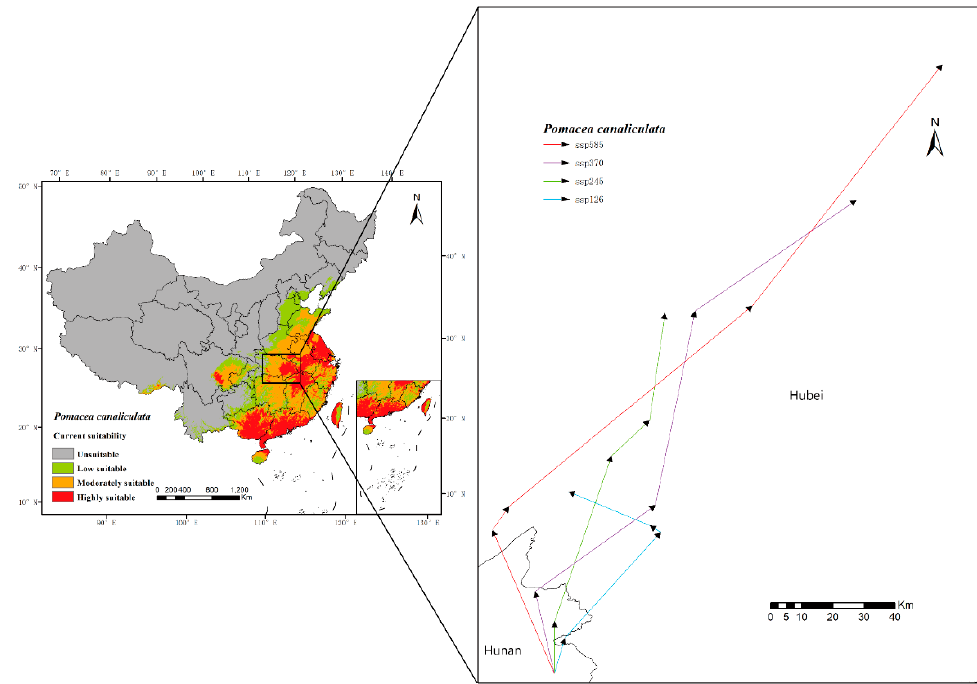
Figure 8. Change in distribution centroid under four SSPs in China from 2021 to 2100, with the distribution centroid shifting from the north of Hunan Province to Hubei Province.